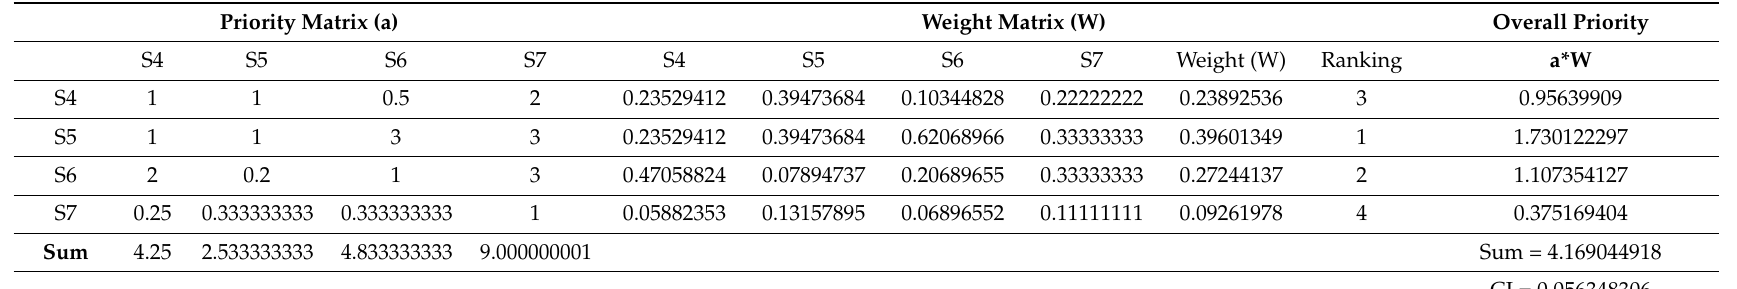
Table 3. Priority calculations for strength factors.